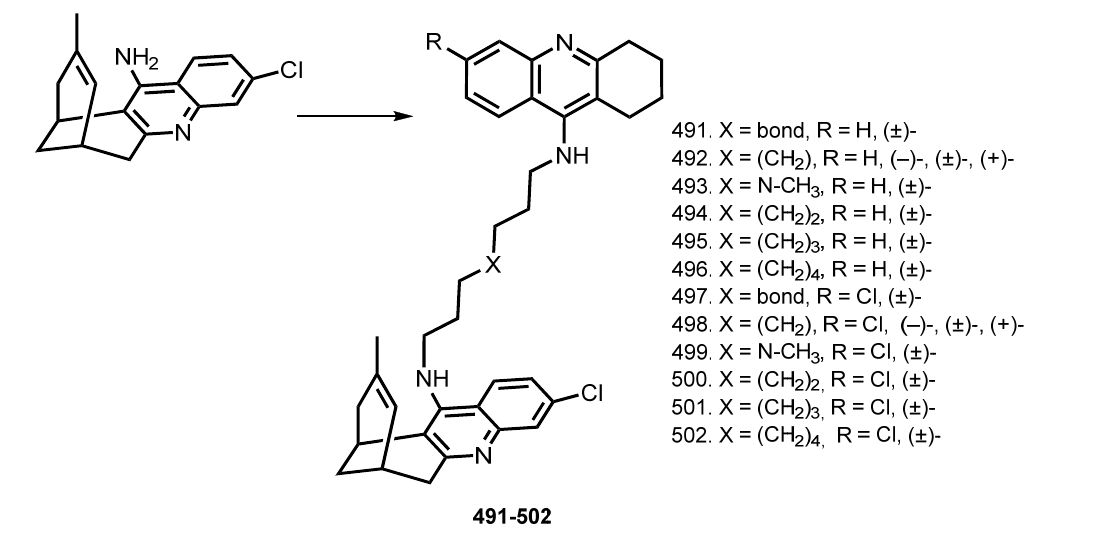
Figure 18. Huprine − tacrine heterodimers 491 – 502 [85]. Expectedly, ChEs inhibitory activity was governed by spacer length. The levorotatory (7S,11S)-huprine-based heterodimers were the eutomers with regard to hAChE inhibition, with ( − )-492 and ( − )-498 being five- to six-fold more potent than the dextrorotatory enantiomers. The most potent hybrids were racemic ( ± )-493 and ( ± )-499 , and ( ± )-491 and ( ± )-497 . Additionally, heterodimers inhibited hAChE-induced A β aggregation and blocked the chaperoning effect of AChE on PrP106 − 126 aggregation. An activity of heterodimers ( − )-492 , (+)-492, ( ± )-492 , ( ± )-494 , and ( ± )-495 toward self-induced A β aggregation and BACE-1 inhibition of hybrids ( ± )-496, ( − )-498 , (+)-498 , and ( ± )-500 – ( ± )-502 were revealed. Finally, ex vivo experiments proved the ability of ( ± )-494 and ( ± )-500 to cross the BBB and inhibit in-brain AChE activity.